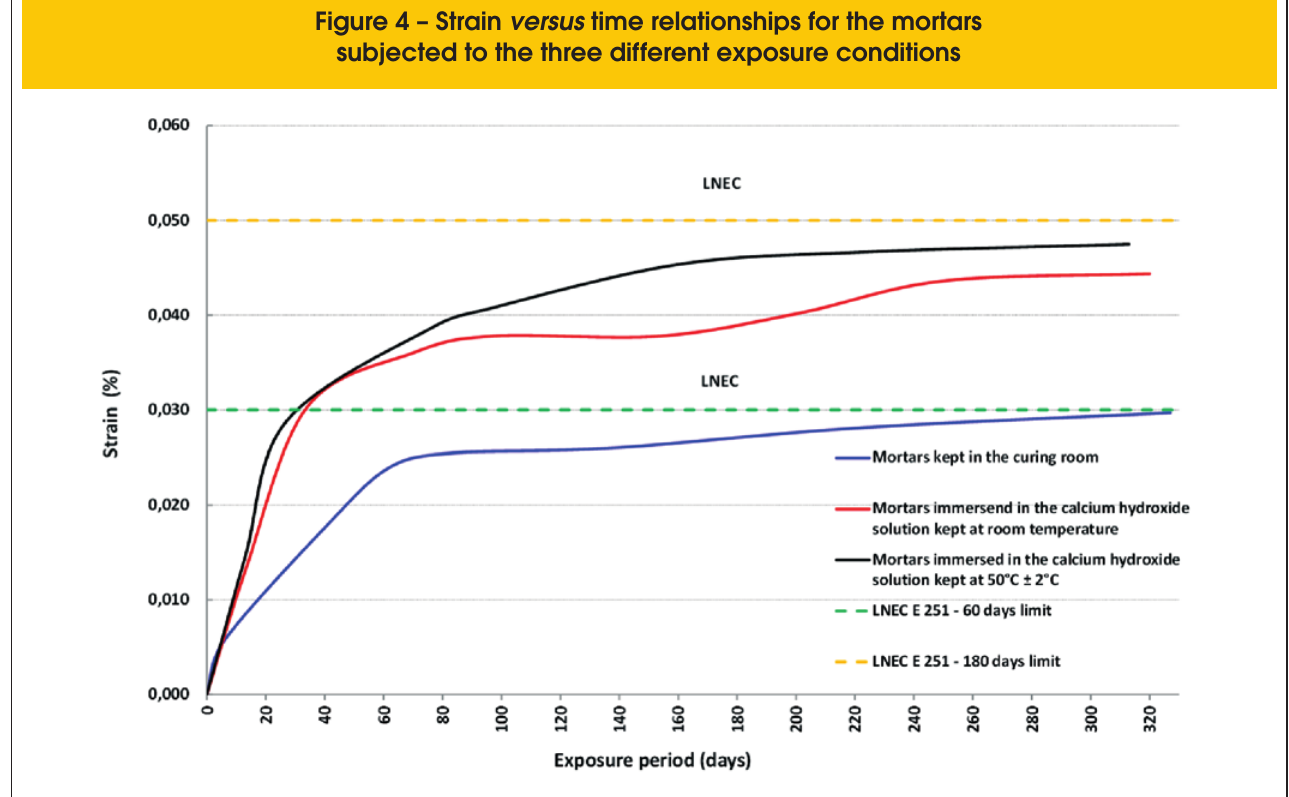
Figure 4 – Strain versus time relationships for the mortars subjected to the three different exposure